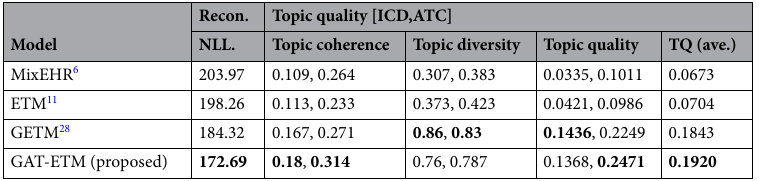
Table 2. Reconstruction loss and topic quality. (Recon., Reconstruction error on the held-out EH data; NLL., negative log-likelihood on the held-out data. Both are the lower the better.). The best score for each metric are in [bold].